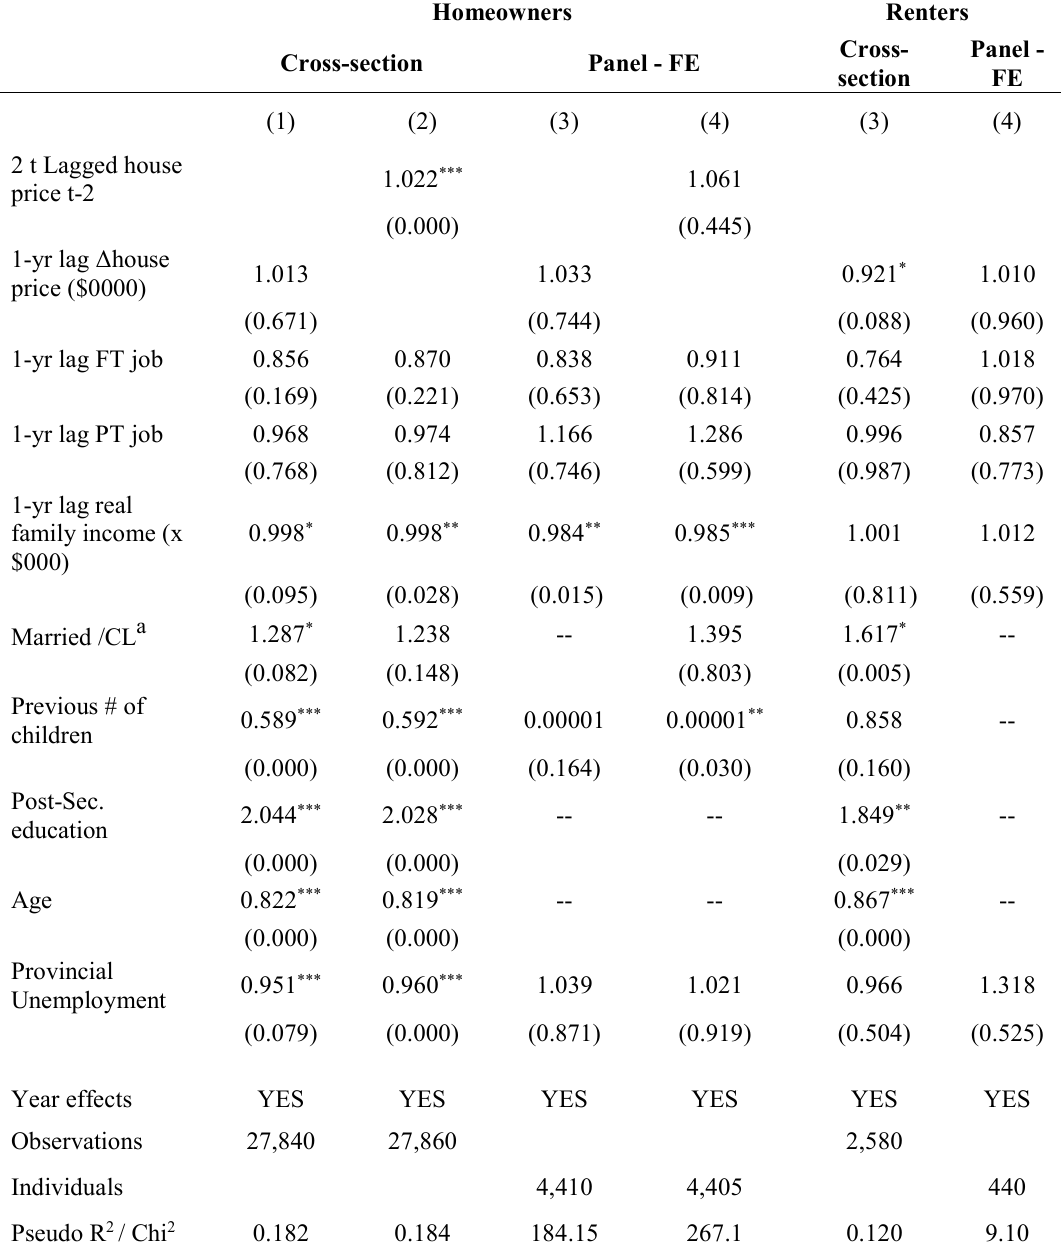
Appendix Table 3 : Effect of house price change and 2-lagged house prices on marginal